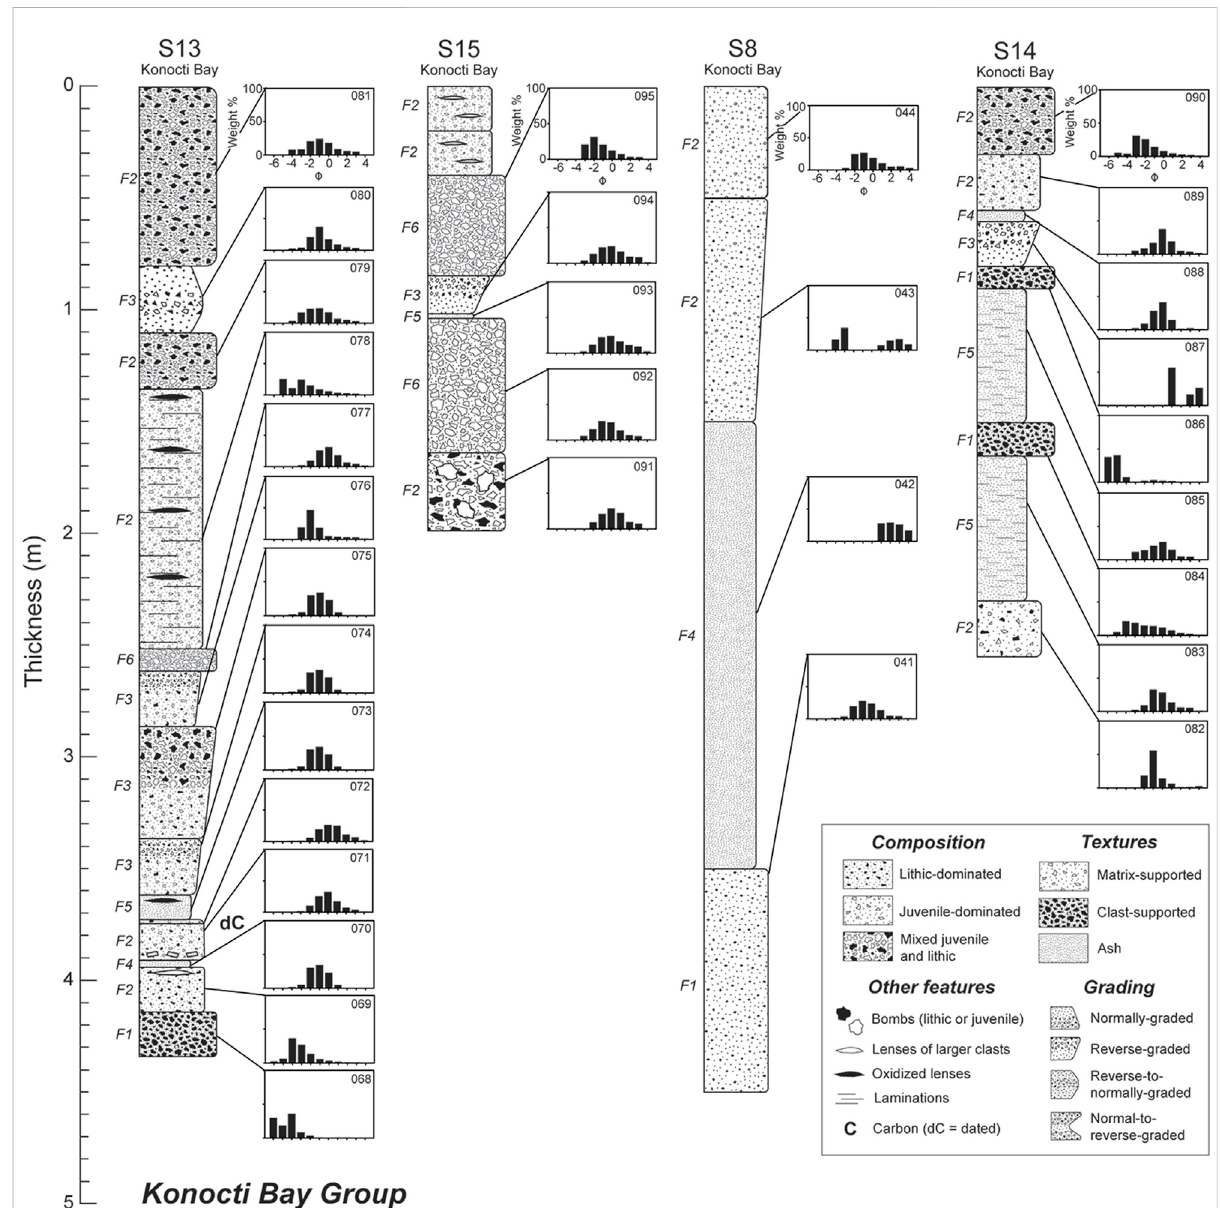
FIGURE 7 Stratigraphy ofoutcropsnearKonocti BayeastofMountKonocti.SeeFigure5captionfor interpretationnotes.Columnsareorderedaccording to their geographic progression from north to south; no correlations or relationships to source vents are implied by this